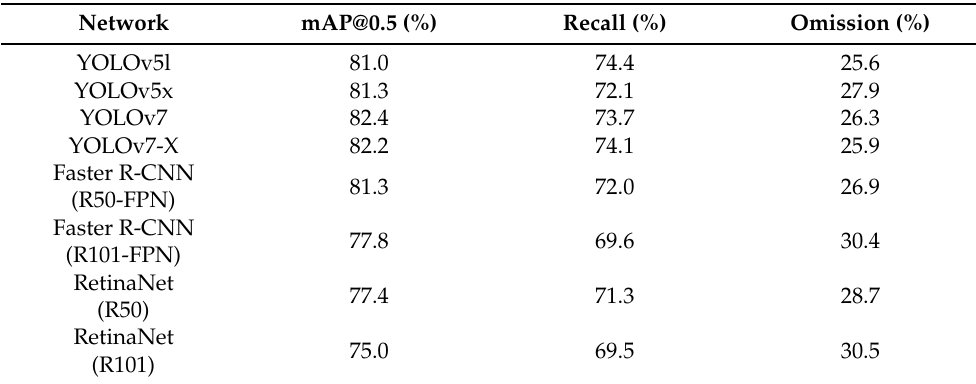
Table 5. The training results based on dataset-3 (division by